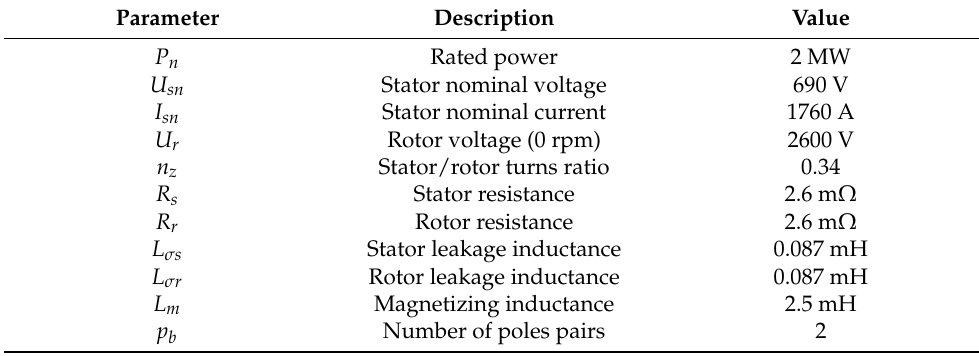
Table 1. 2 MW DFIG nominal